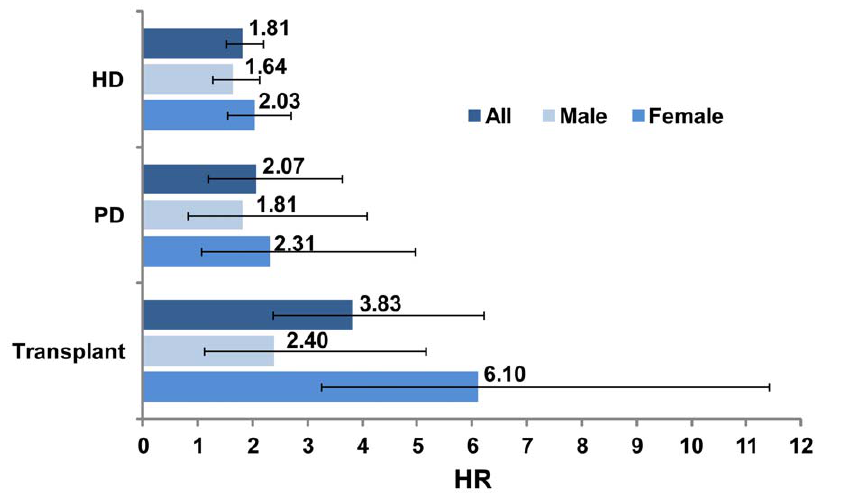
Figure 1. Hazard ratio and 95% confidence interval of overall cancer associated with end-stage renal disease in Cox’s regression analysis by adjusted for age, sex, and medical history of hypertension, hyperlipidima, and diabetes.